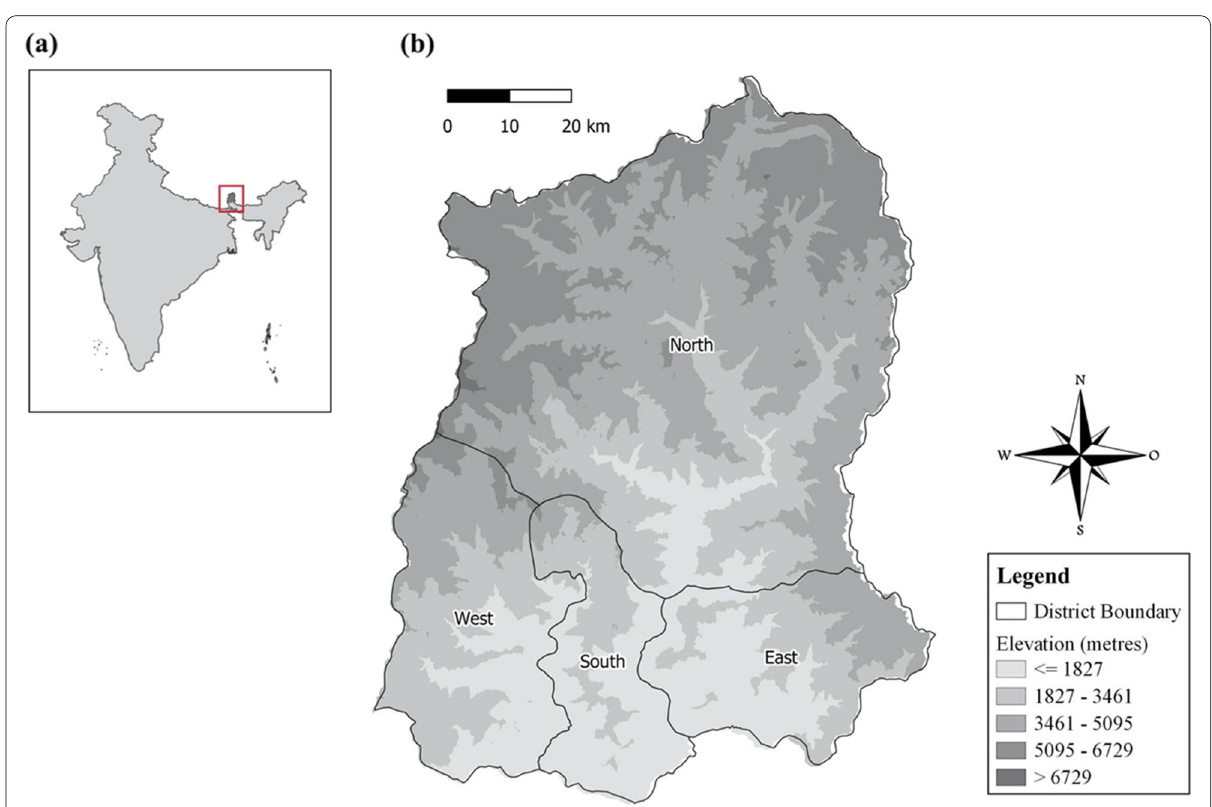
Fig. 1 a Location of Sikkim in India, b the four districts of